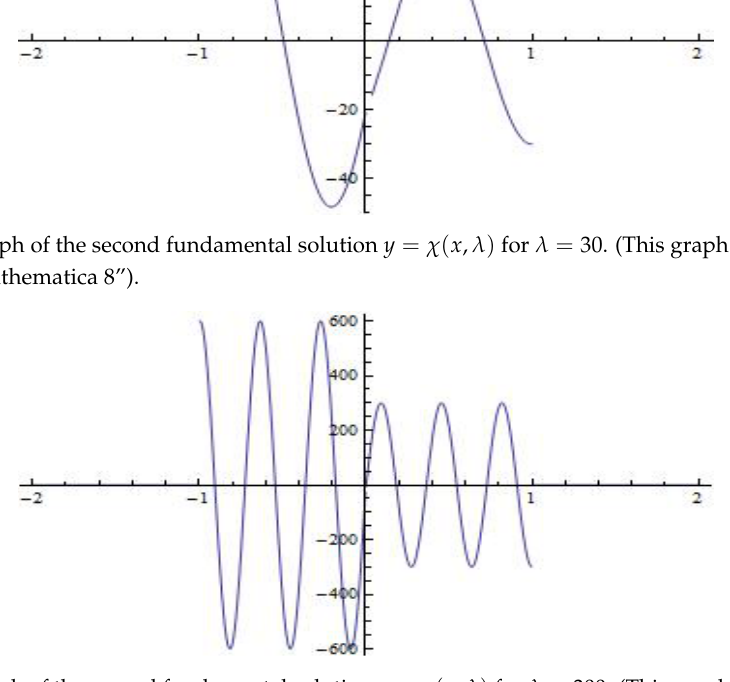
Figure 7. Graph of the second fundamental solution y = χ ( x , λ ) for λ = 300. (This graph was sketched by using “Mathematica